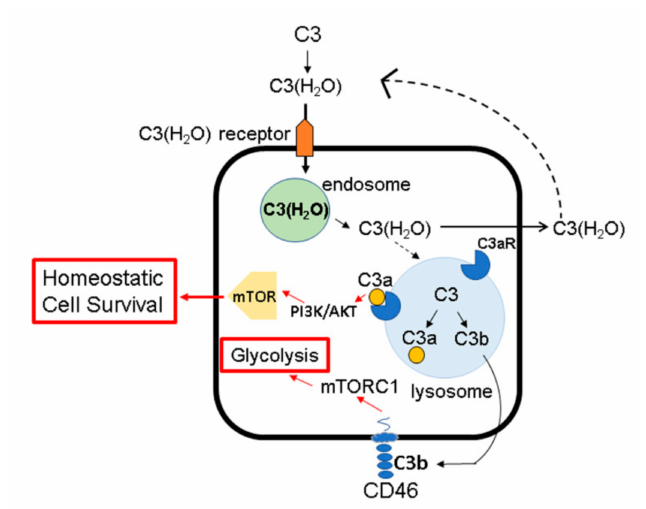
Figure 4. Intracellular C3 and CD46 drive cell metabolism and survival. Intracellular C3 is biosynthetically derived or can be loaded from the plasma. Generation of C3a and C3b from intracellular C3 can induce metabolic pathways through the PI3K-AKT-mTOR axis, enhancing glycolysis and homeostatic cell